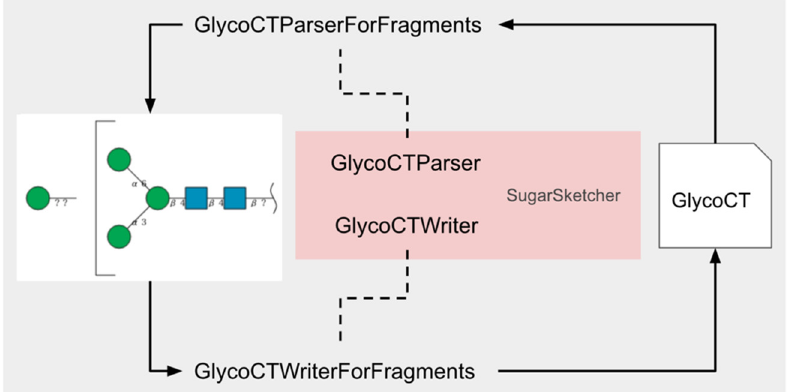
Figure 9. Schematic diagram of GlycoCT conversion process.